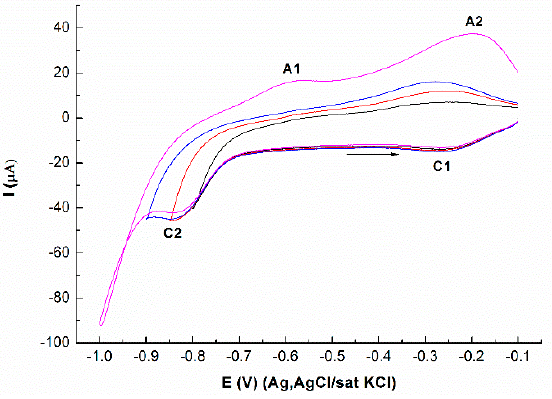
Figure 1. Cyclic voltammograms of 7 mM MoO 42 − on Ag(111) in a pH 9.2 ammonia buffer solution, different end scan. The scan rate is 50 mV·s − 1 .